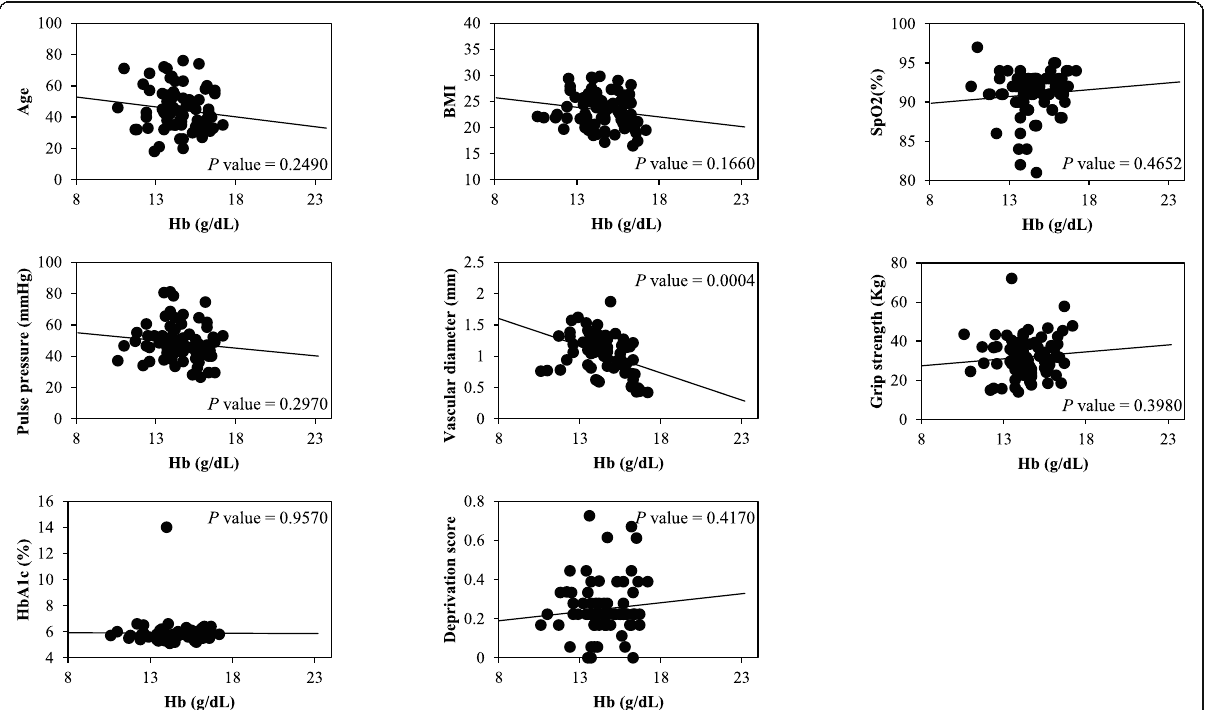
Fig. 2 Linear regression analysis of Hb and each variable in males. Each variable was plotted against the Hb concentration in male participants. The p value indicates the result of linear regression analysis of Hb and each variable. Only vascular diameter was found to be significantly correlated with